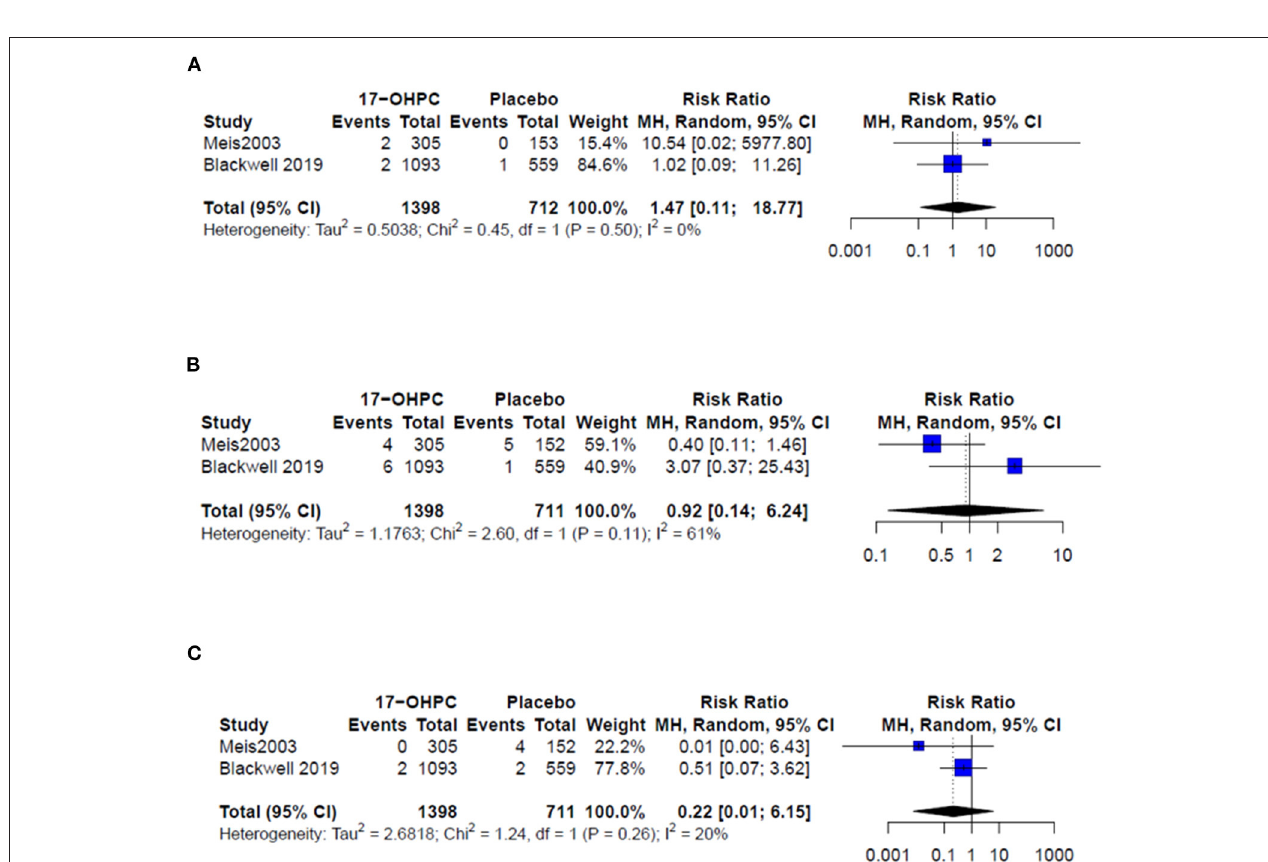
FIGURE 5 | Forest plots of the risks of recurrent PTB below (A) grade 3 or 4 intravascular hemorrhage, (B) bronchopulmonary dysplasia, and (C) necrotizing enterocolitis.